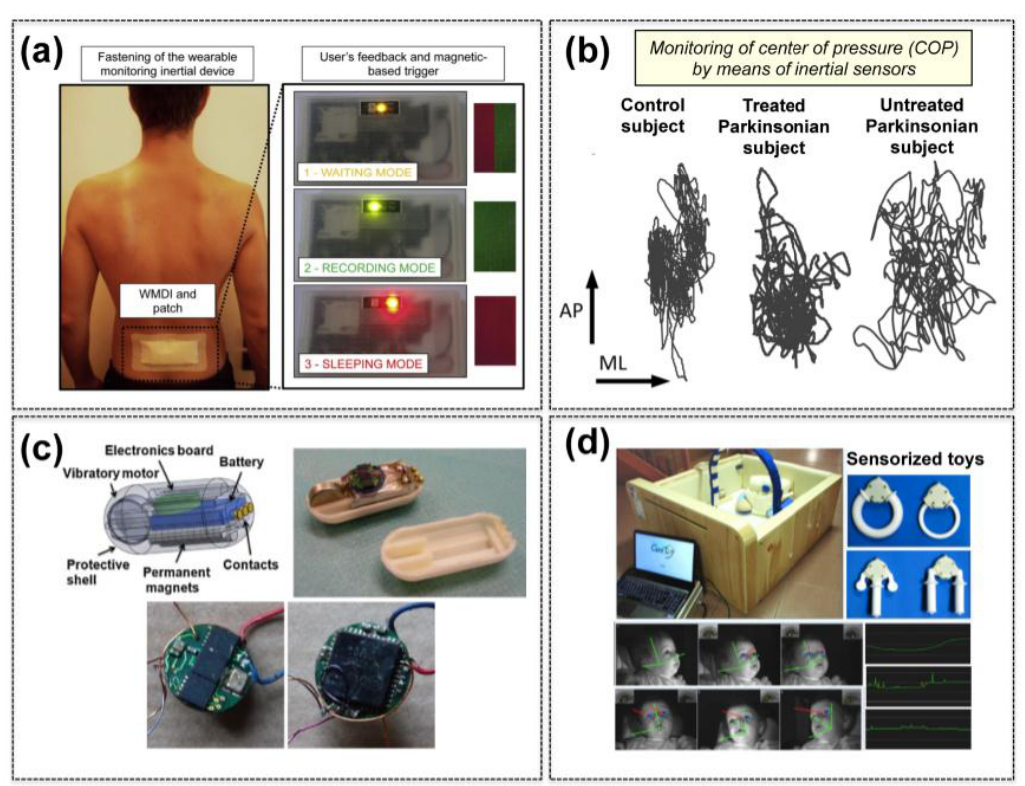
Figure 1. Examples of MEMS for medical applications. ( a ) Wearable monitoring inertial device for measuring sexual performance. Adapted with permission from [16] (copyright: Elsevier); ( b ) Center of pressure displacement maps obtained by means of tri-axial accelerometers mounted on healthy and Parkinsonian subjects. AP = antero-posterior plane, ML = medio-lateral plane. Adapted with permission from [24] (copyright: Creative Commons); ( c ) Endoscopic capsules provided with inertial sensors for vibratory motor control. Adapted with permission from [34] (copyright: Elsevier); ( d ) MEMS integrated in toys for monitoring preterm infants at risk of neurodevelopmental disorders. Adapted with permission from [38] (copyright: Creative